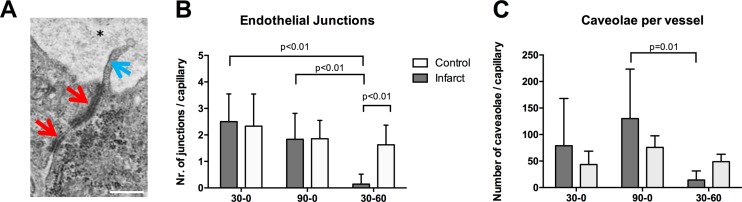
Endothelial junctions and caveolae.Quantification of endothelial cell-cell junctions. A Typical TEM image of a part of two endothelial cells with cell-cell junctions (red arrows). Protruding into the lumen of the capillary (asterisk) marginal fold can be seen (blue arrow). White bar represents 100 nanometer. Magnification 17500x. B Quantitative analysis showing the mean number of cell-cell junctions per capillary in the infarct zones in all three groups. C Mean number of endothelial caveolae per capillary, as determined with transmission electron microscopy.